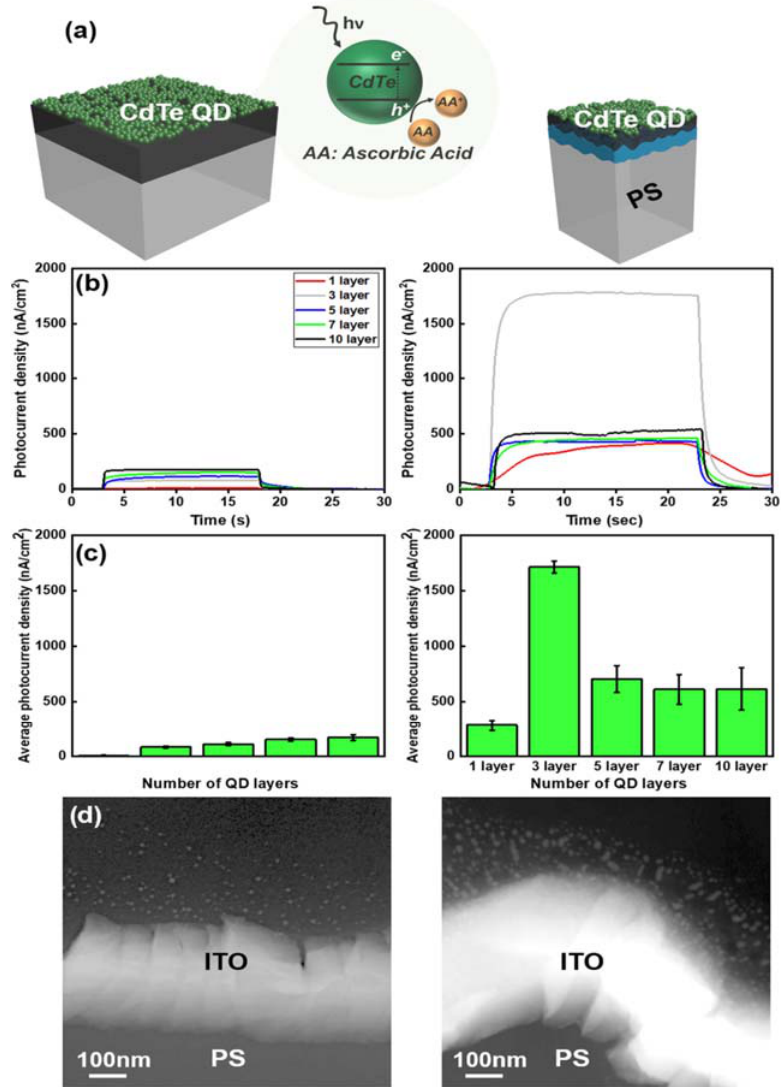
Figure 7. Photoelectric compound (PEC) measurements at planar and scaffolded-wrinkled photoelectrodes. ( a ) Visible light (470 nm) induces electron/hole pairs in CdTe quantum dots (QDs). Holes oxidize ascorbic acid, generating an anodic redox current. ( b ) PEC current densities measured on planar ( left ) and scaffolded-wrinkled ( right ) devices using 100 mM ascorbic acid at 0 V with respect to Ag/AgCl. The QD layers are increased by depositing alternate layers of QDs and poly (diallyl dimethylammonium chloride) (PDDA). The 470 nm light-emitting diode is turned on at 3 s and turned off at 23 s. ( c ) The average PEC current densities measured on planar ( left ) and scaffolded-wrinkled ( right ) devices for different numbers of QD layers. ( d ) Scanning transmission electron micrographs of cross-sections of planar ( left ) and scaffolded-wrinkled ( right ) devices. The imaged devices contain three QD layers Reprinted with permission from ref. [20]. 2018 American Chemistry